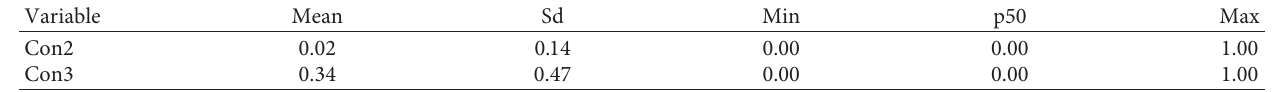
Table 9: Descriptive statistics of Con2 and